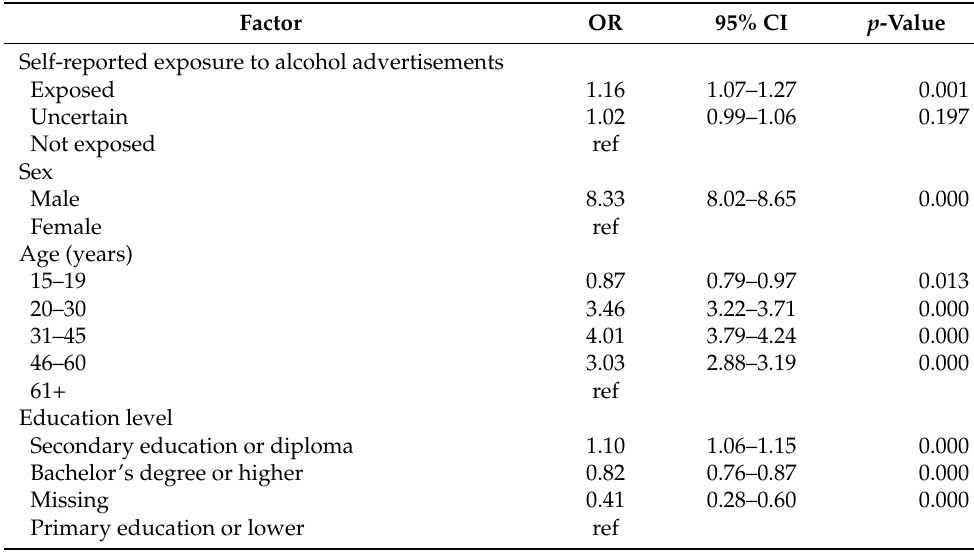
Table 3. Factors associated with past-year drinking (Model 1; n =